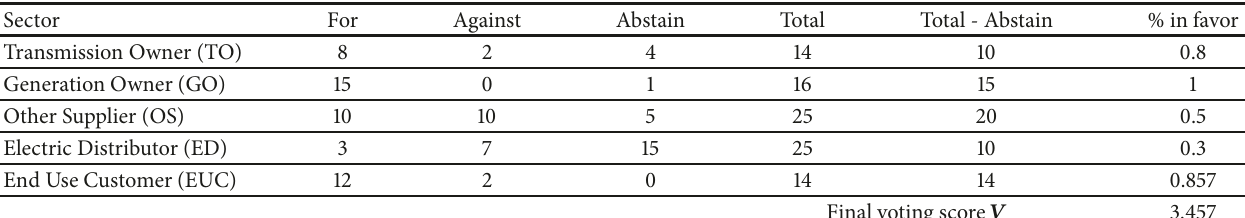
Table 2: Sector-weighted voting example. Source: